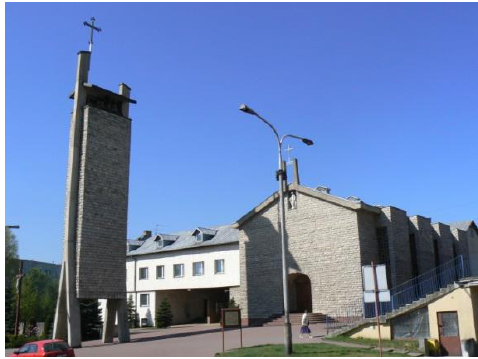
Figure 11. Church of the Visitation of the Blessed Virgin Mary in Częstochowa (built in 1984–90).